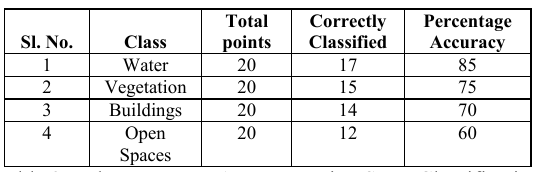
Table 2: Urban Features Accuracy using SVM Classification